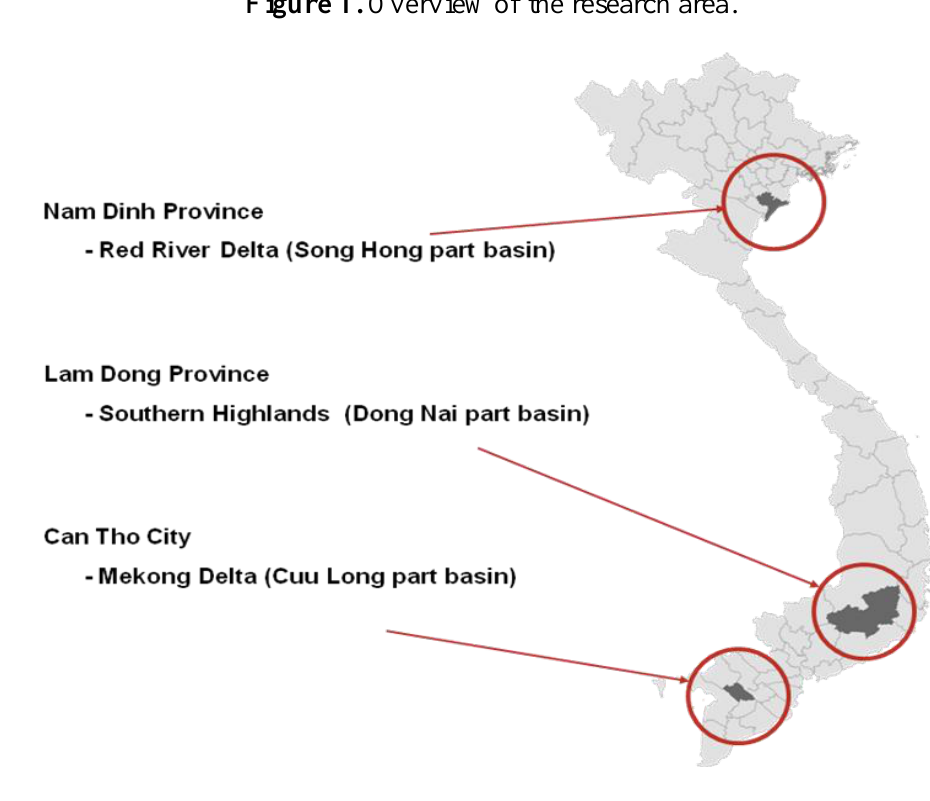
Figure 1. Overview of the research